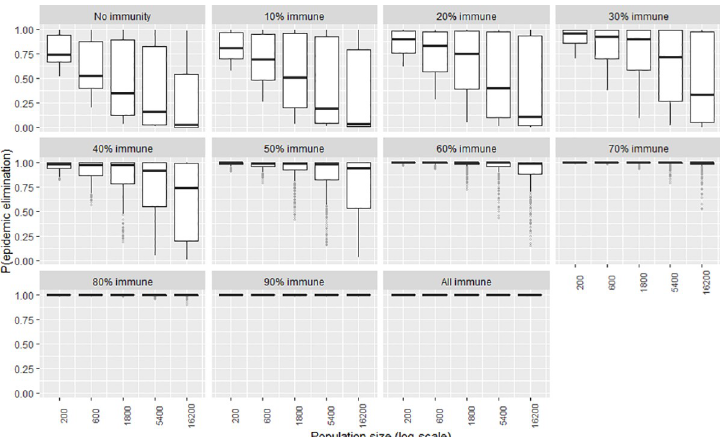
Fig 7. The certainty of the effect of population size on P(elim.) at different herd immunities. The range of possible values when other parameters not shown in this plot are varied over their ranges. The boxplot shows the median, the interquartile range, minimums and maximums (1.5 times the 1 st and 3 rd quarter values) and outliers (grey circles).